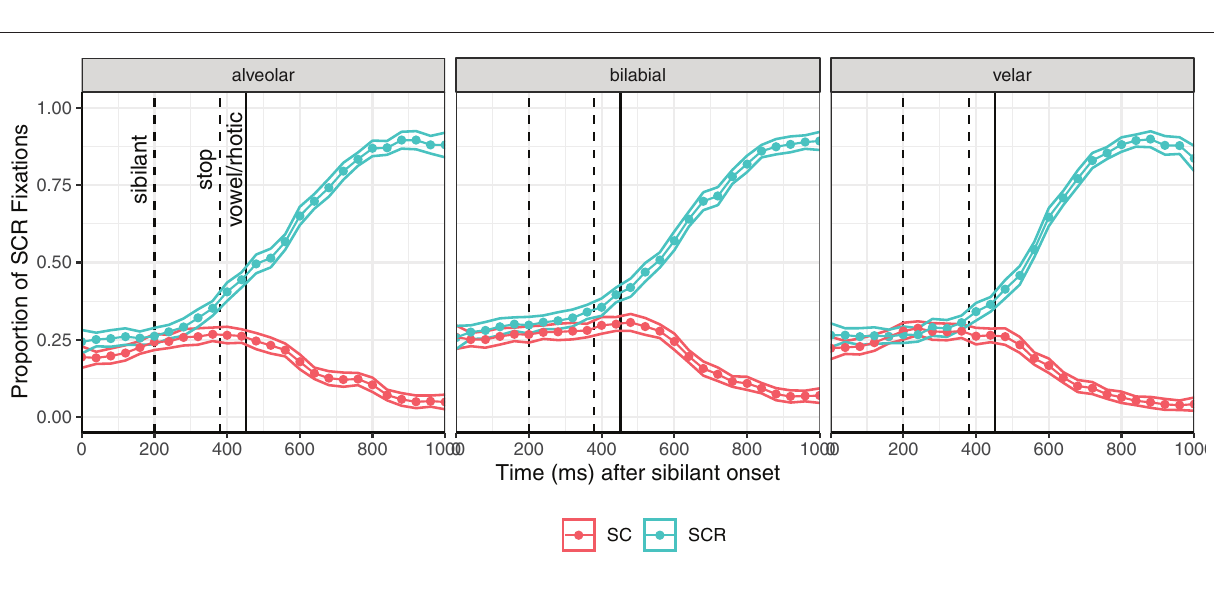
FIGURE 4 | Fixation proportion for /sCr/ clusters (y-axis) by time following the sibilant onset (x-axis, binned into 40 ms windows), cluster type (color: /sC/ = red circles, /sCr/ = teal triangles), and place of articulation (columns). The vertical lines represent a 200 ms delay from the onset of the sibilant, stop, and vowel/rhotic. A fixation executed during the sibilant interval would be observed between the black dashed vertical